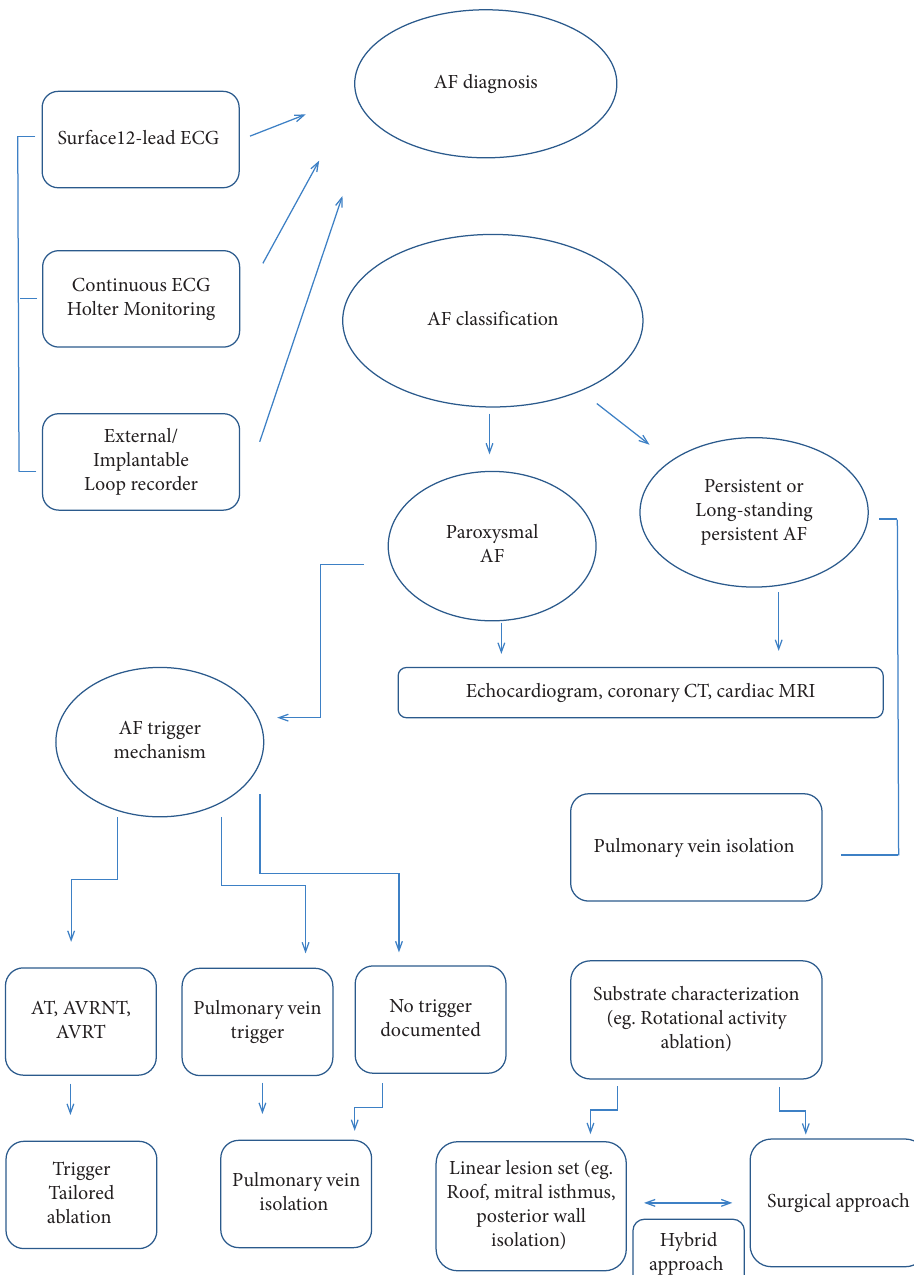
Figure 6: Stepwise approach to atrial fibrillation patient (AF: atrial fibrillation, AT: atrial tachycardia, AVRNT: atrioventricular reentrant nodal tachycardia, AVRT: atrioventricular reentrant tachycardia, CT: computed tomography, and MRI: magnetic resonance